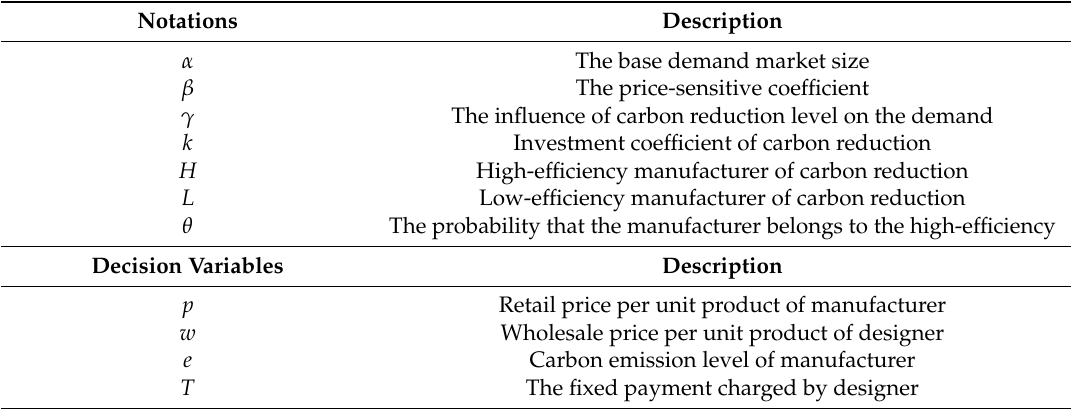
Table 1. Notations